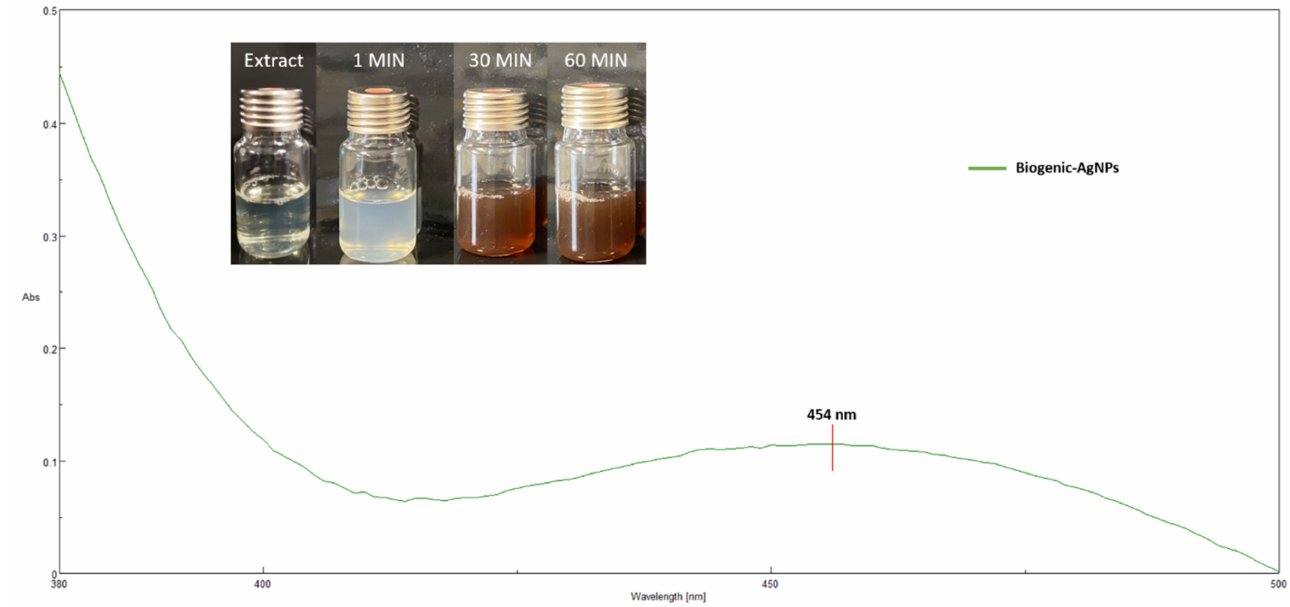
Figure 1. UV-spectrum of Iris tuberosa extract and Biogenic-AgNPs. Inset shows the change in color of the silver nanoparticle